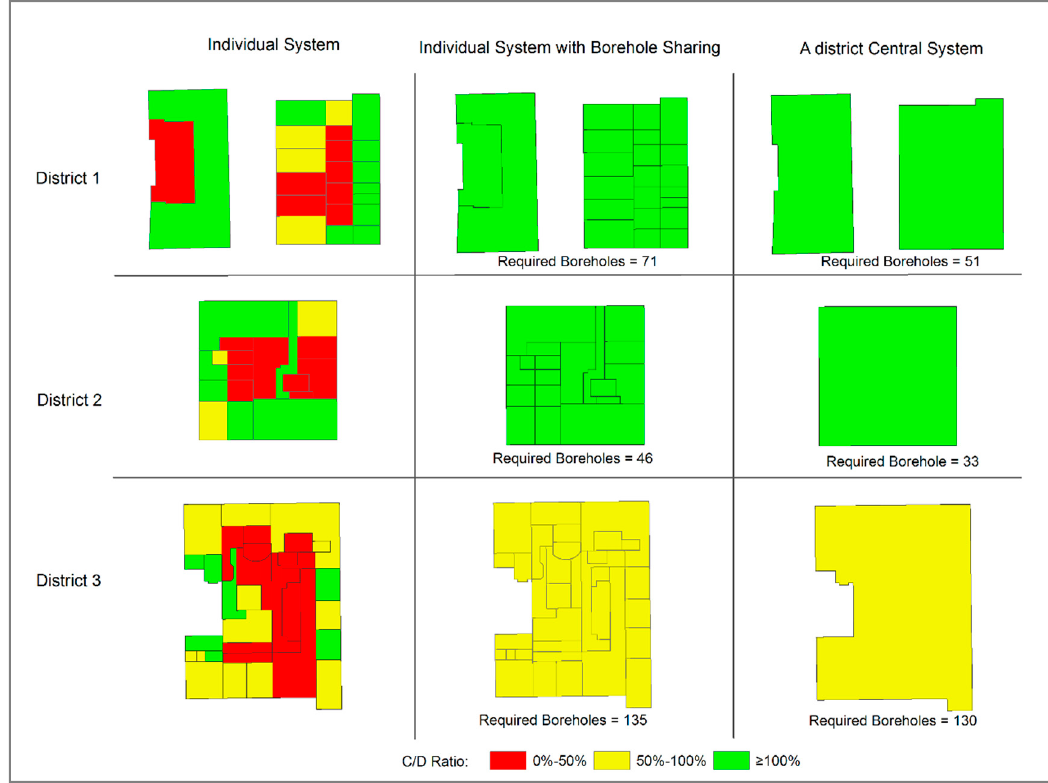
Figure 6. District sharing systems comparison (Scenario 2). Table 3. C / D ratios with various sharing strategies under Scenario 1 and Scenario